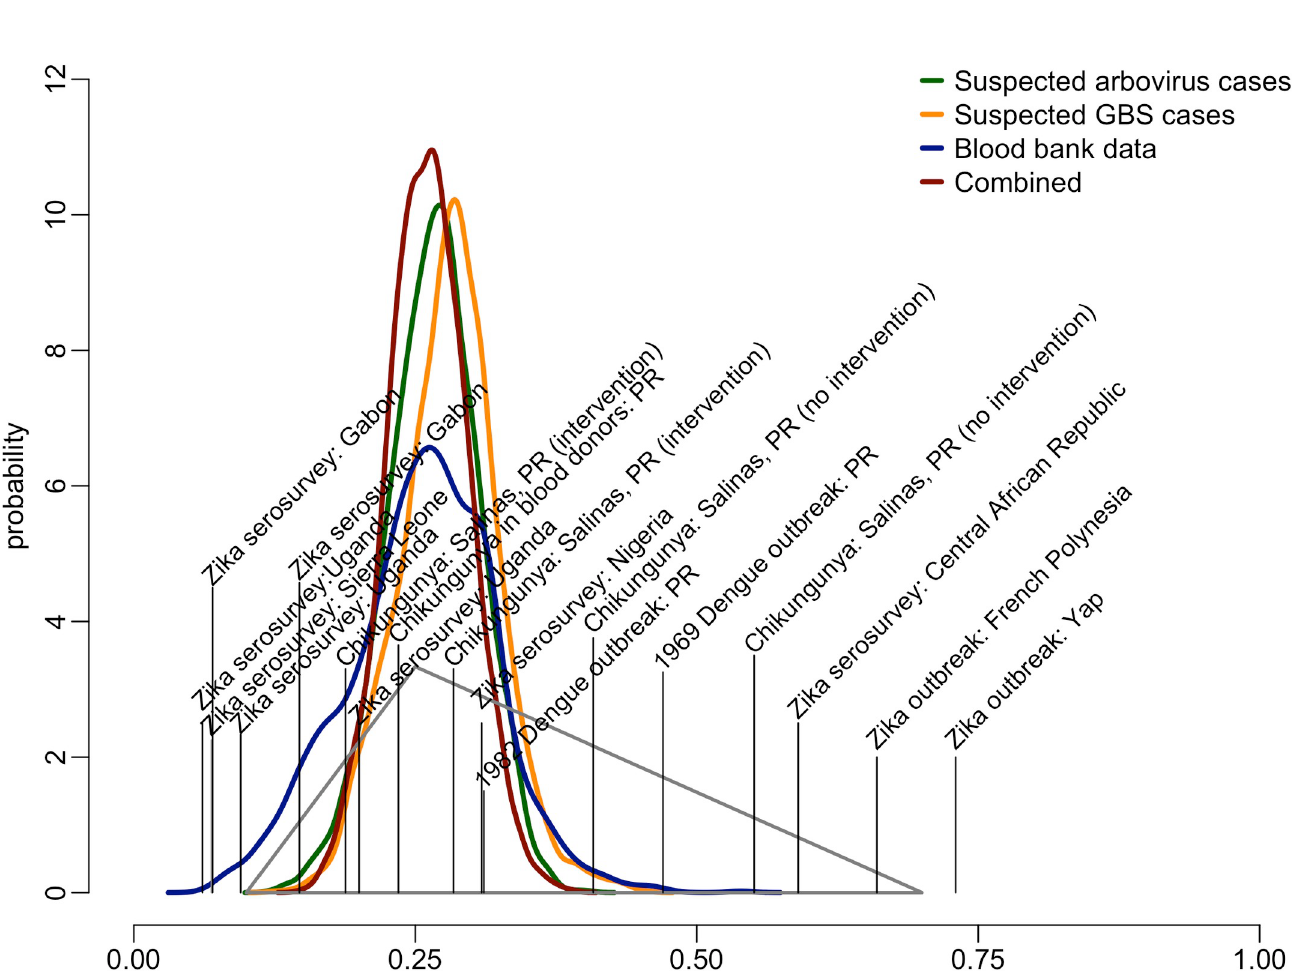
Fig 2. Estimated probability distribution for the proportion of incident ZIKV infections in Puerto Rico in 2016, and probabilities obtained from published literature. The triangle represents the estimated distribution of possible incident infections from a priori estimates [13,14] based on previous Zika serosurveys (vertical lines), Zika outbreaks and other arboviral outbreaks in Puerto Rico studies published literature [5,15–25].Thick lines represent the distribution of the proportion infected estimated from combined surveillance indicators (dark red), and separate surveillance indicators.